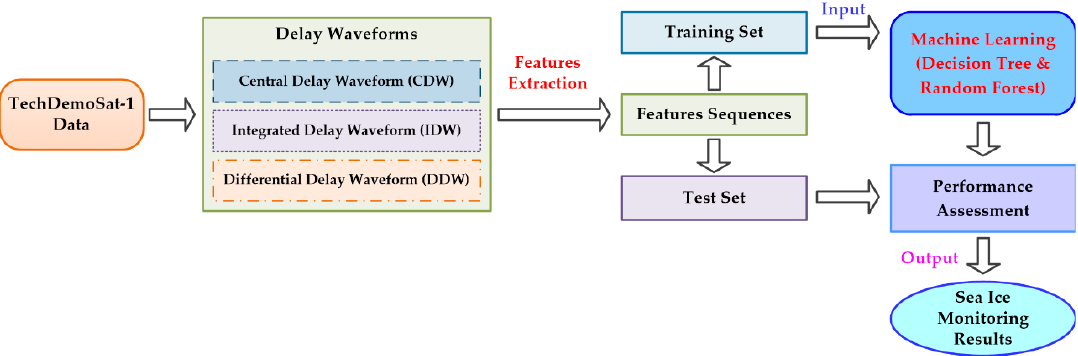
Figure 7. Flowchart of GNSS-R and machine-learning-based sea ice detection.